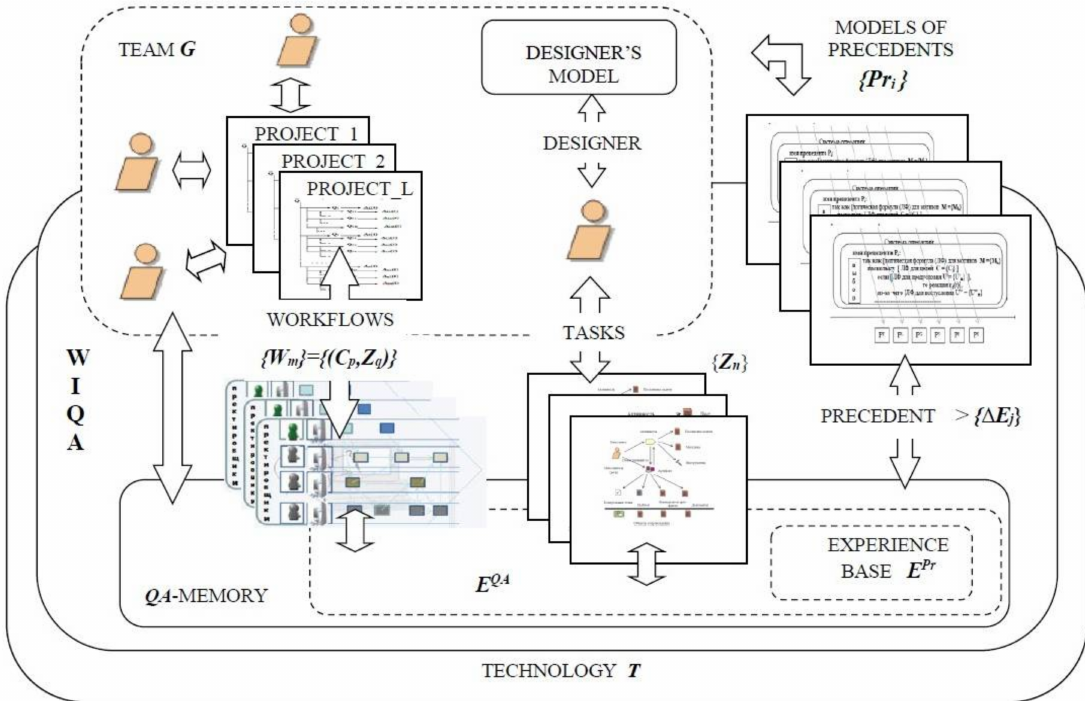
Figure 3. Some details of operational